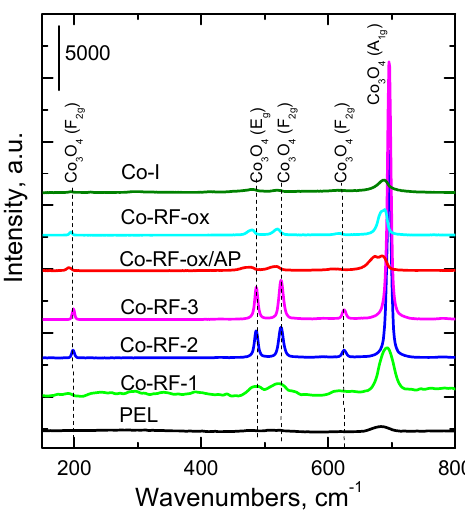
Figure 2. Raman spectra of the examined supported cobalt oxide catalysts.